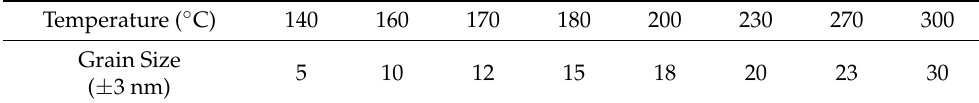
Table 1. Mean Ge 2 Sb 2 Te 5 grain sizes as functions of annealing